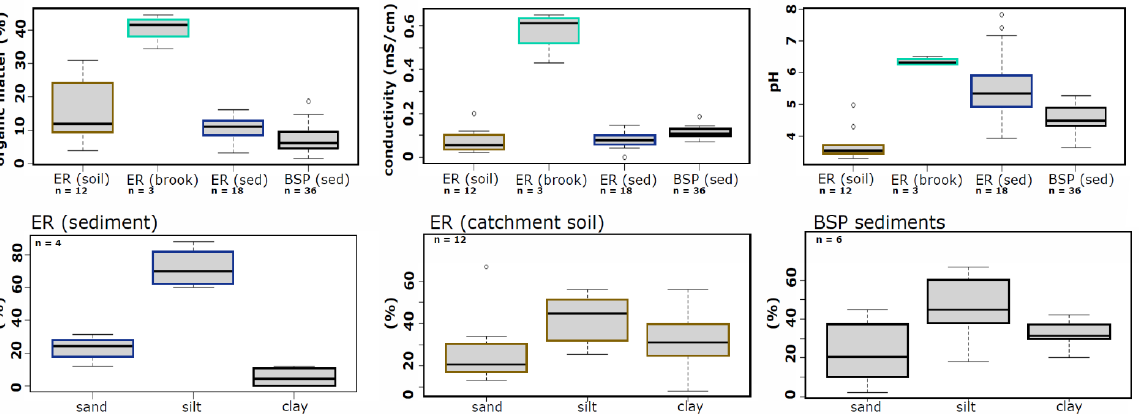
Figure 3. Boxplot diagrams of the organic matter, electrical conductivity, pH value and grain size distribution in the samples from the Einsiedel Reservoir (ER) and the Berthelsdorf Smelter Pond (BSP). Values outside the 10th and 90th percentiles are symbolised by a “ ∘ ” . The organic matter content in the Einsiedel Reservoir varied between 3.2% and 16.2%, had a relatively high median value (11.0%) and was possibly favoured by the or-